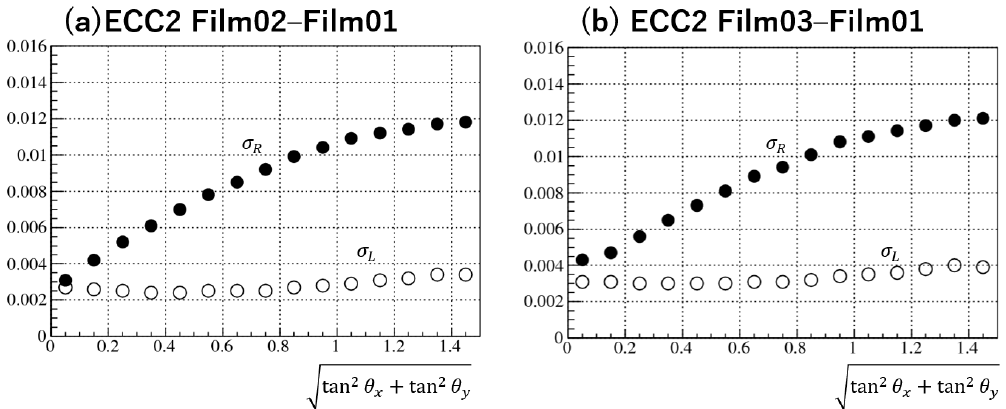
(cid:113) tan 2 θ x + tan 2 θ y . The values were determined by the ECC and used to calculate the